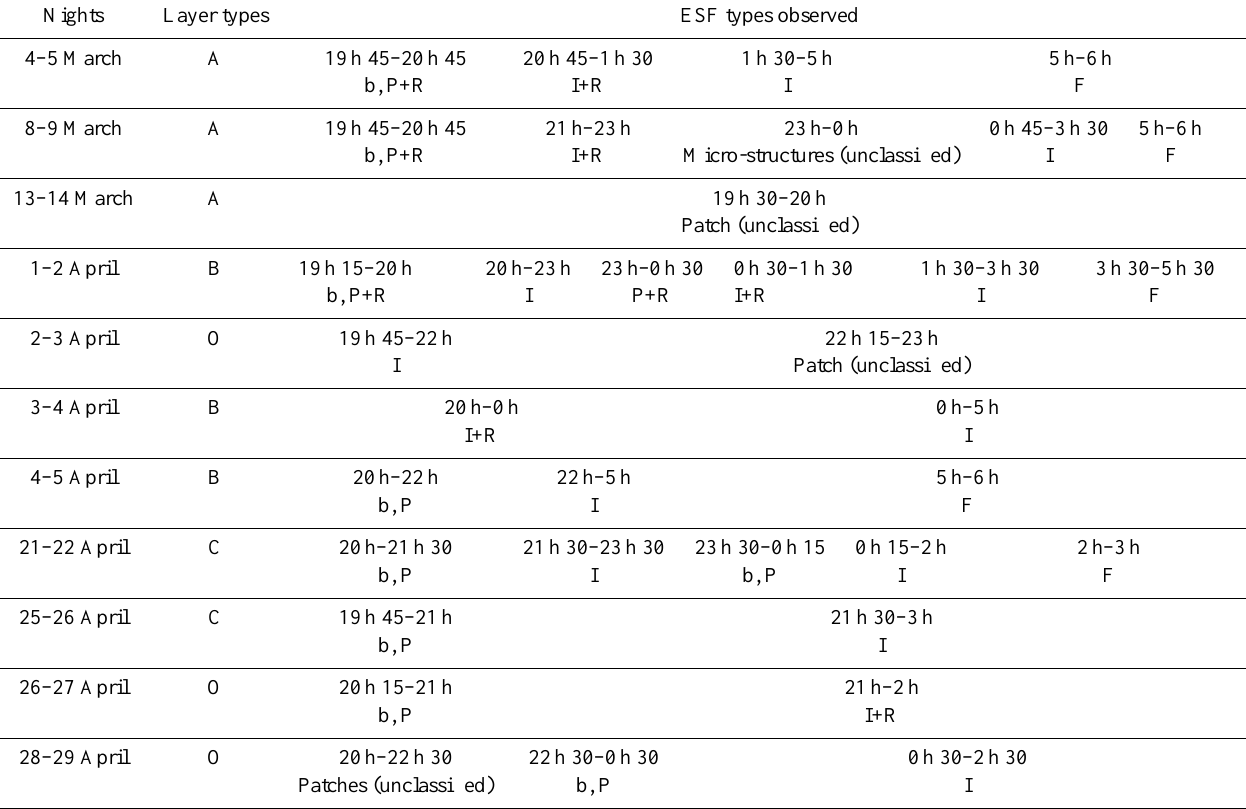
Table 4. ESF sequences observed over the night as a function of the F-layer profiles. The b-type ESFs correspond to small echoes at the bottom of the F-layer (Fig. 7a), the P-type to large-scale structures near the peak of the F-layer (Fig. 7b), the I-type to echoes emerging near the bottom and extending inside the F-layer (Fig. 7d). The R and F-type ESFs are the classical range and frequency spread echoes. The chain of events b, P+R, I+R, F is the most frequently